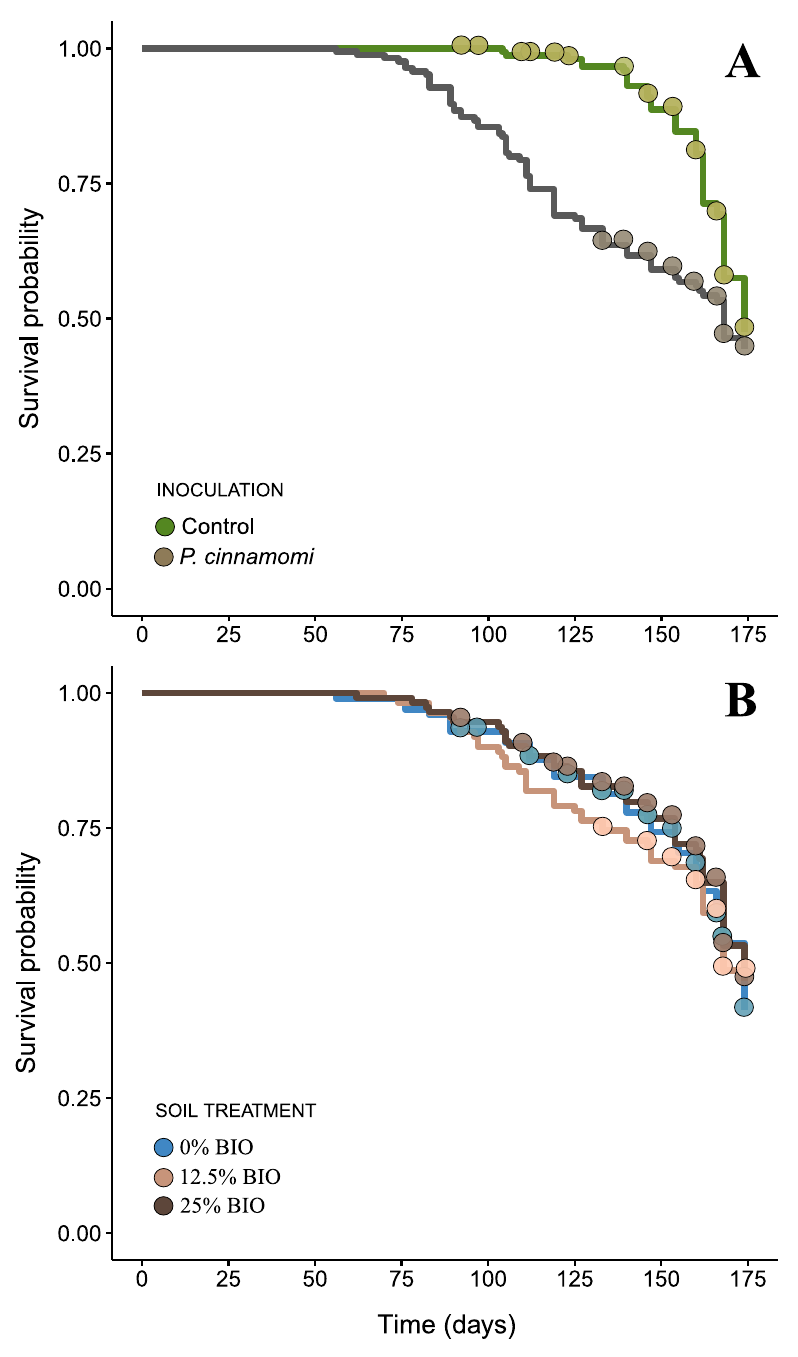
Figure 2. Survival probability of Q. ilex plants since plant emergence, depending on the infection by P. cinnamomi ( A ) using mock-inoculated plants vs. P. cinnamomi -inoculated plants, and the Biohumin ® concentration treatments ( B ) with 0, 12.5, and 25% BIO proportion in substrate. Dots indicate measures taken during experiment, and lines are the predicted values by the model.